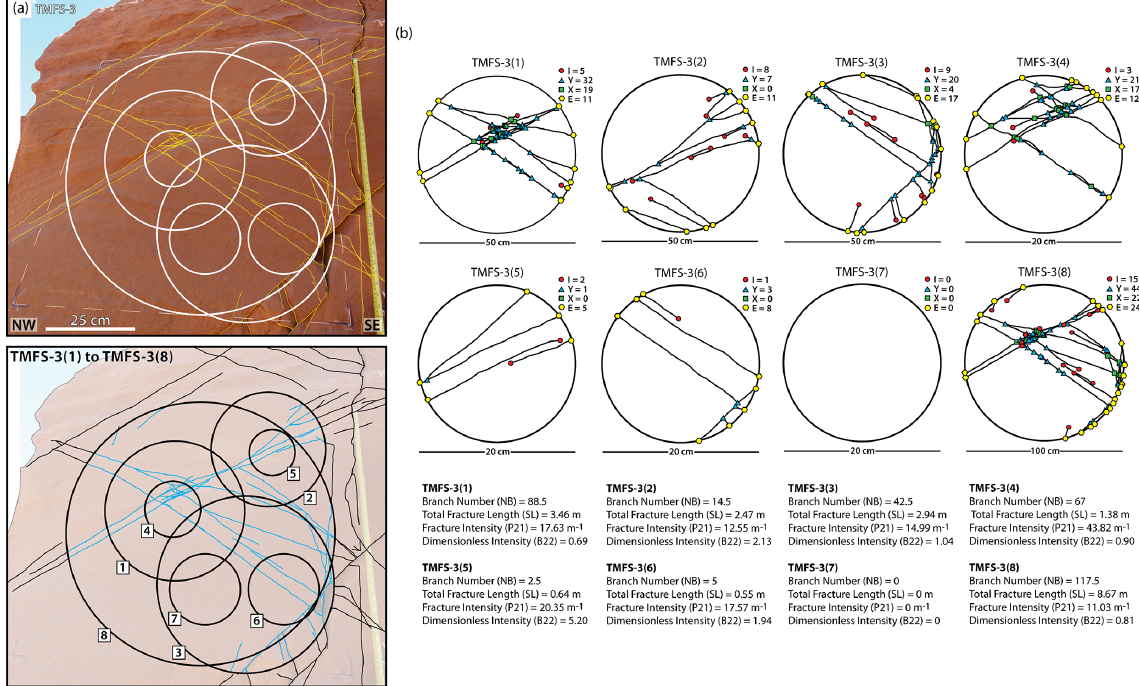
Figure A3. Sample station TMFS-3 scan circles (a) and nodal analysis (b) with statistics.